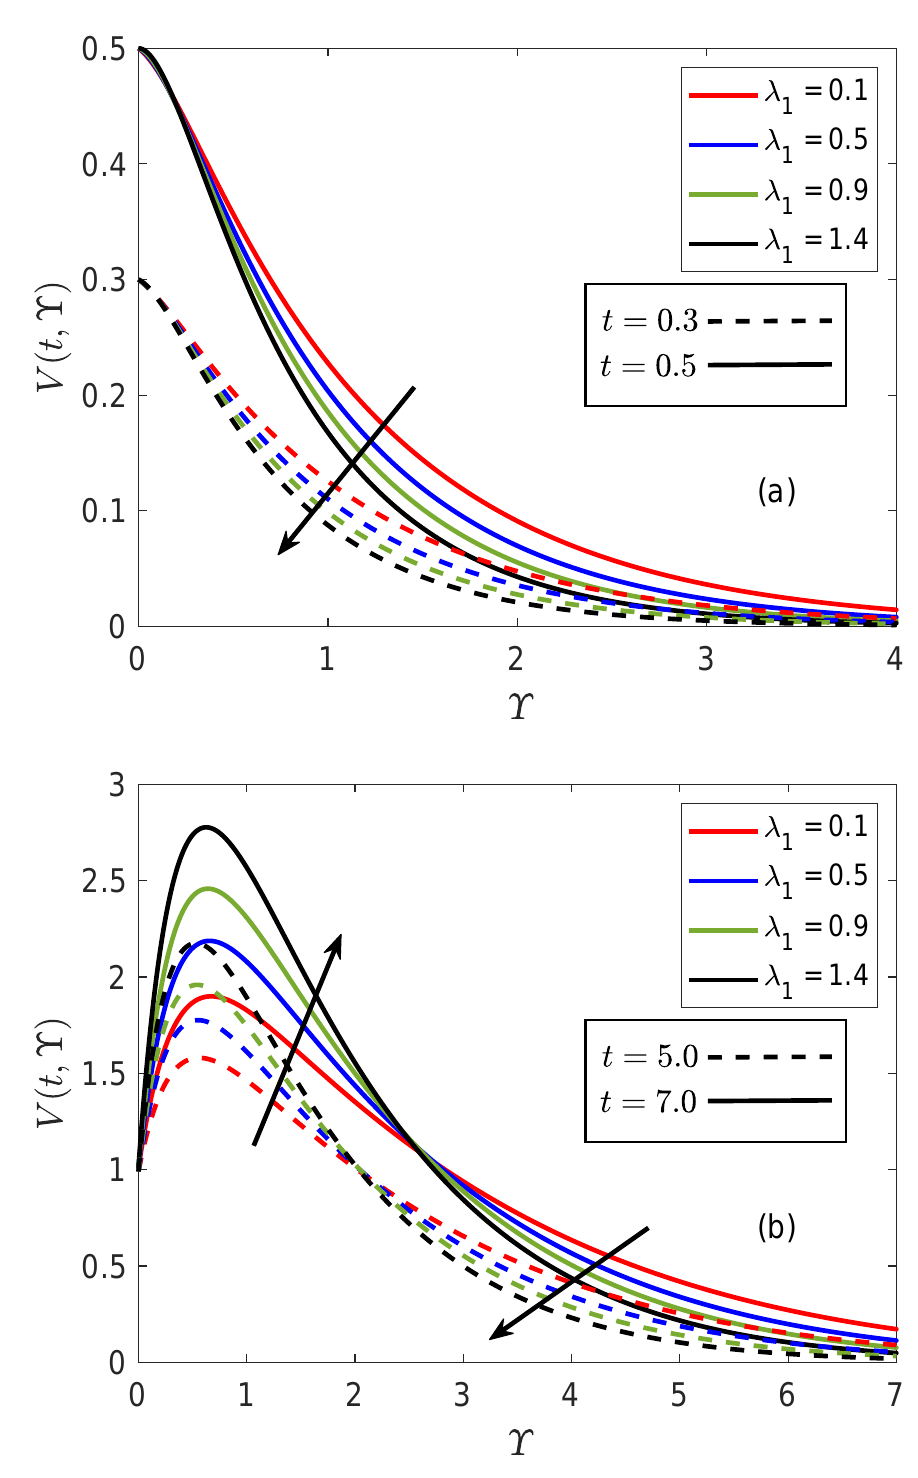
Figure 11. ( a ) Flow patterns corresponding to variations of λ 1 for smaller time inputs. ( b ) Flow patterns corresponding to variations of λ 1 for larger time